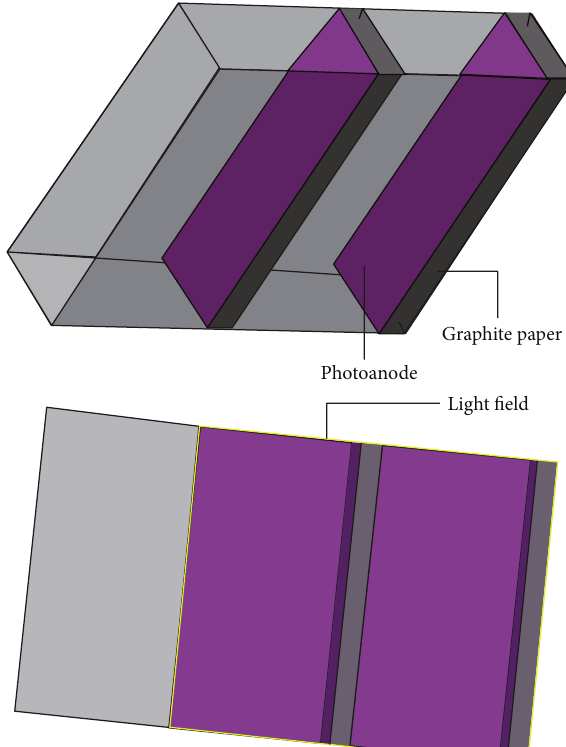
Figure 2: Schematic diagram of inclined DSSC